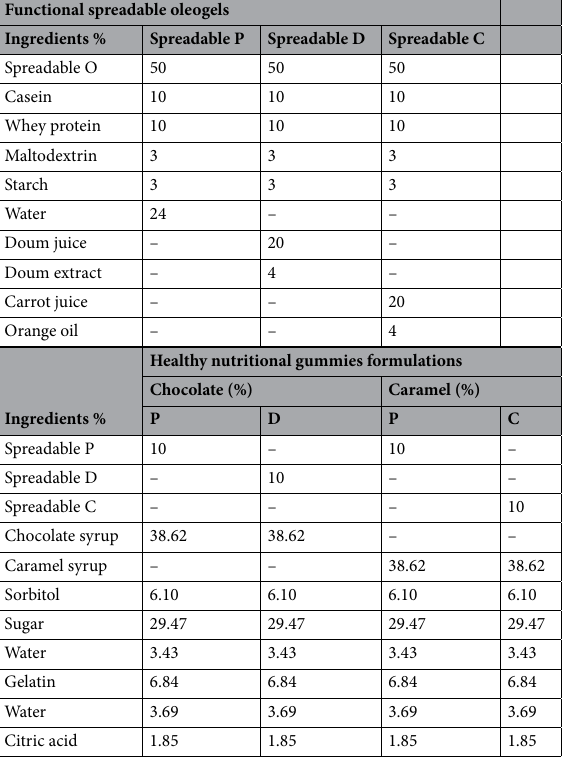
Table 1. Functional spreadable oleogels and healthy nutritional gummy